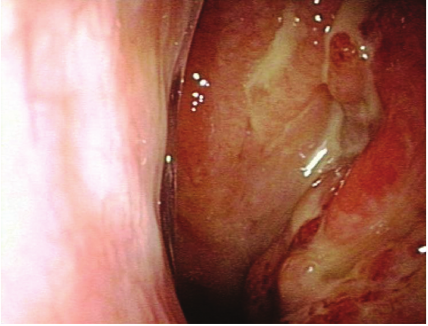
Figure 1: Fibroscopic exam showed the presence of an ulcerated mass of the